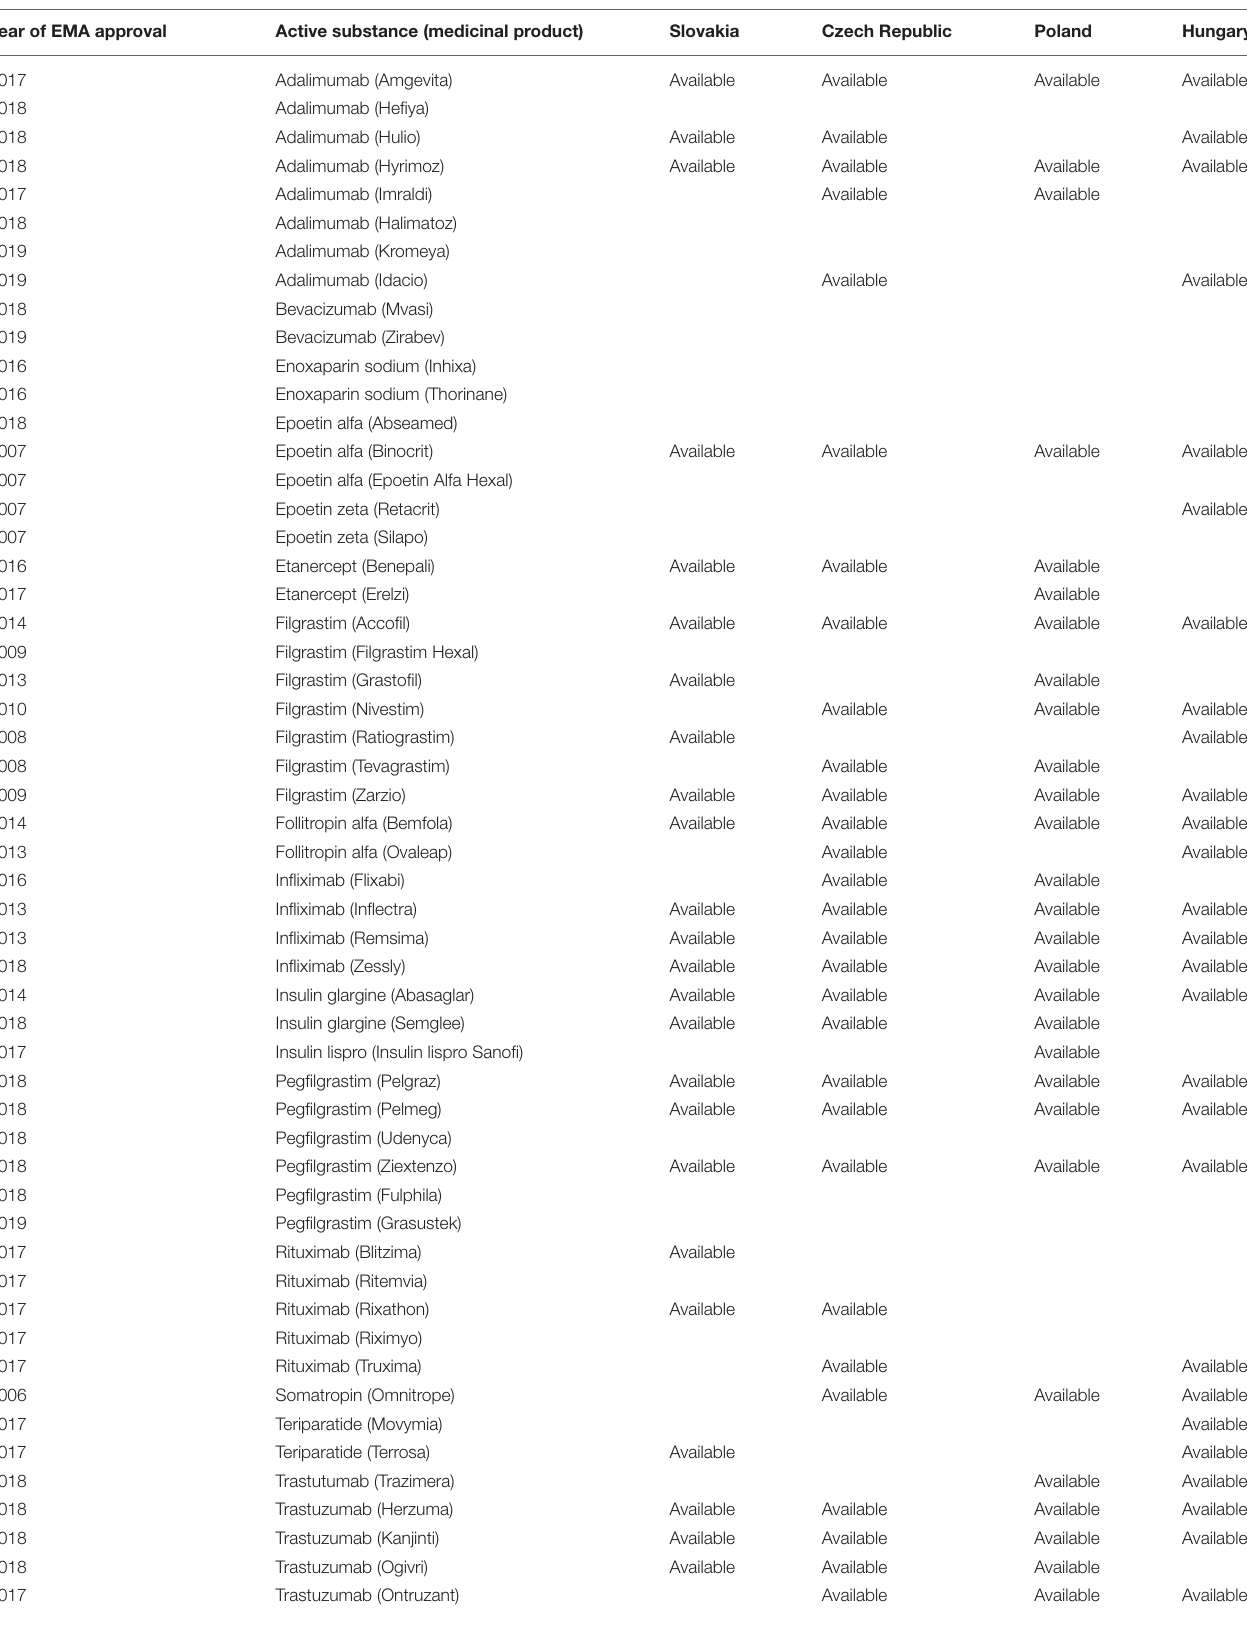
TABLE 1 | Availability of biosimilars in Slovakia in August